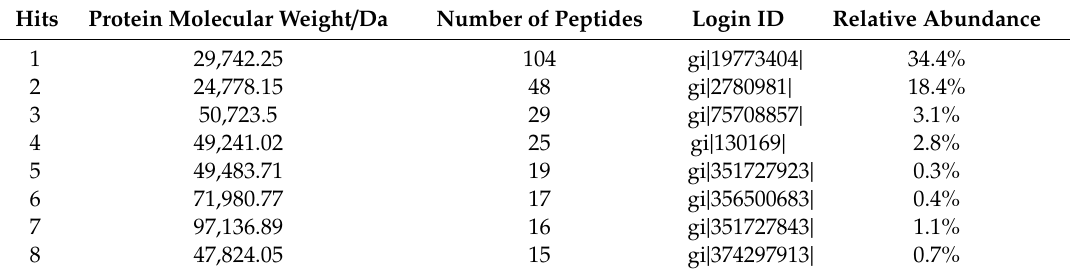
Table 3. The test results of unknown sample by Nano LC-ESI-MS / MS.